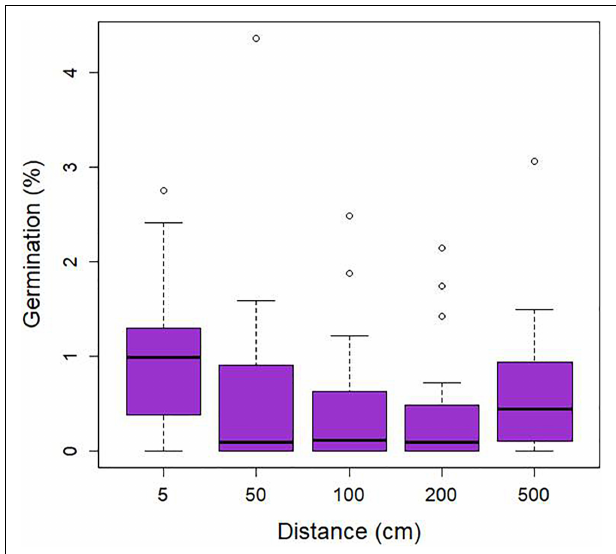
FIGURE 4 | Relationship between the percentage seed germination of Gastrodia confusoides and distance from adult plants (cm) measured in four plots in bamboo forest in Taiwan.